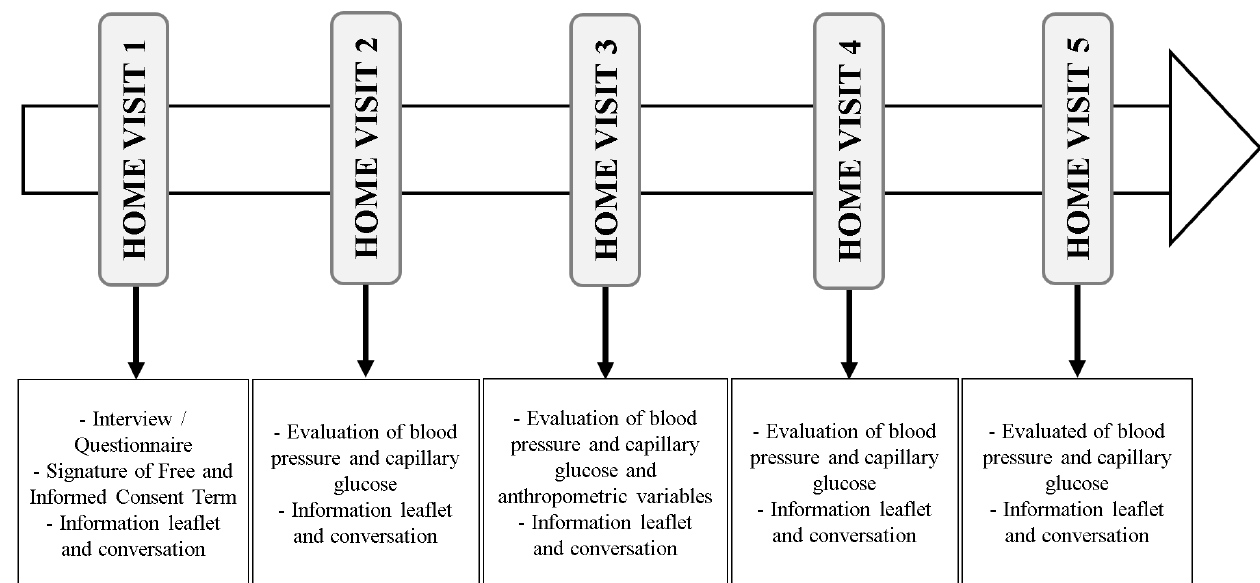
FIGURE 1 – Study design and data collection of all home